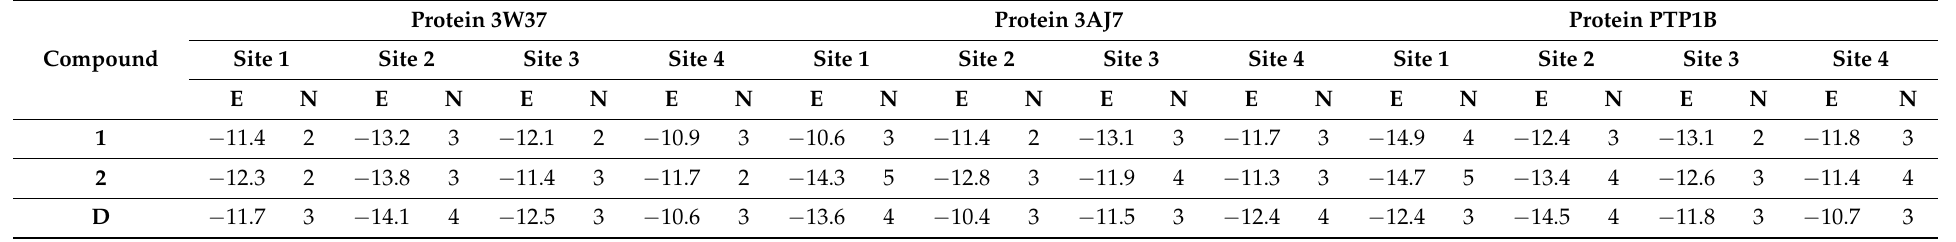
Table 4. Prescreening results on inhibitability of investigated compounds 1, 2 and the commercialized drug voglibose ( D ) towards the potential sites on proteins 3W37, 3AJ7, and PTP1B.